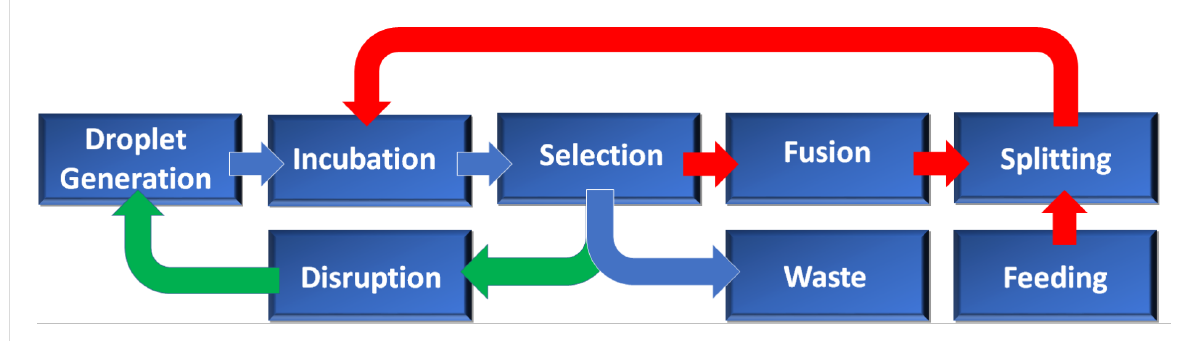
Figure 6: Process of the automated microfluidic platform, in which recursive evolution is applied at both individual droplet and sub-population level. Blue arrows indicate processes common to all devices; green arrows indicate processes unique to sub-population selection; red arrows indicate pro- cesses unique to individual droplet selection.